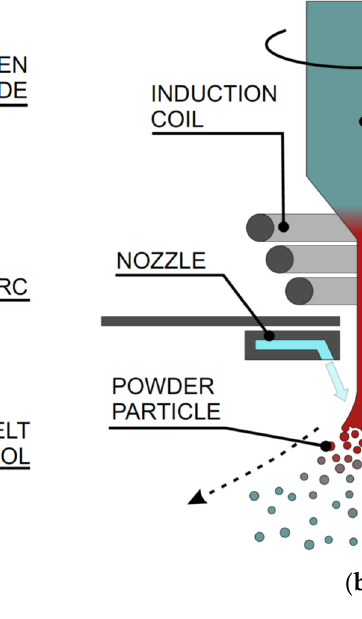
Figure 1. Schemes of UA ( a ) and EIGA ( b ).